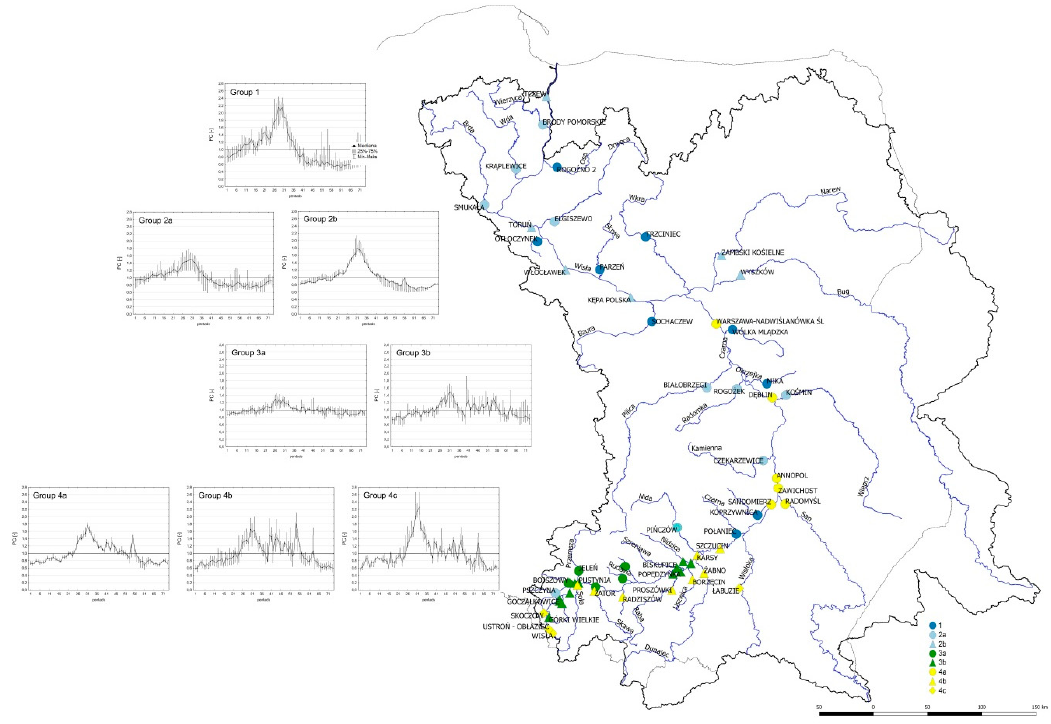
Figure 5. Spatial distribution of rivers in distinguished groups taking as a criterion grouping of monthly flow rates and range of their variability in average annual cycle and range of variability of PPC in the separated groups of gauges.